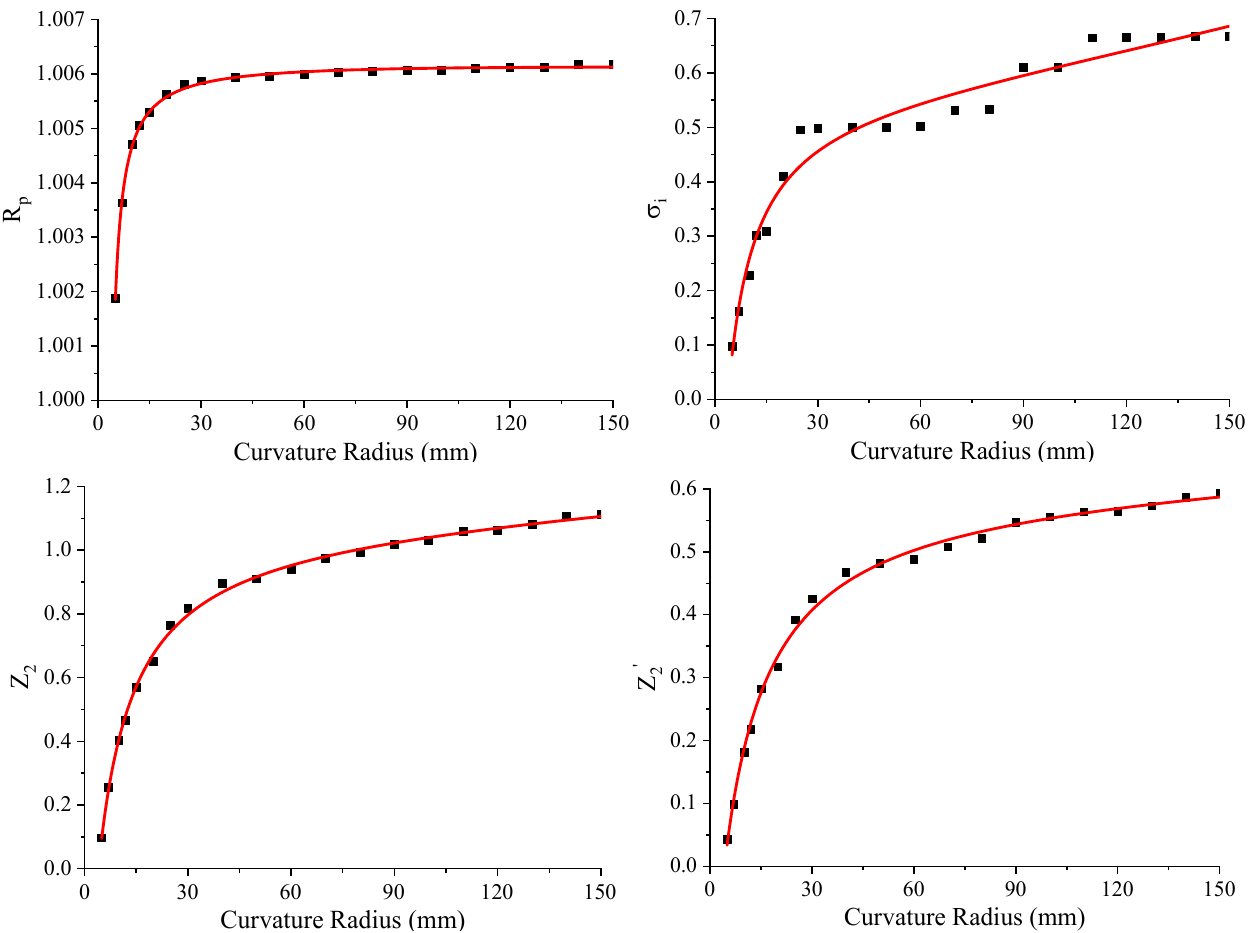
Figure 9. Roughness under different curvature radius thresholds.